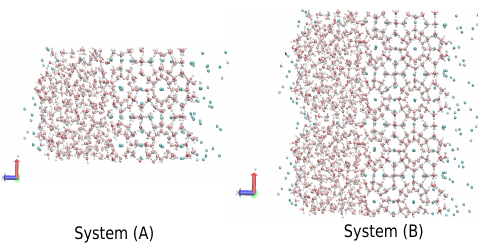
Figure 12. Systems used as seed for all the simulations of the methane-liquid water-sI hydrate, red arrow indicates x-axis and blue arrow indicates